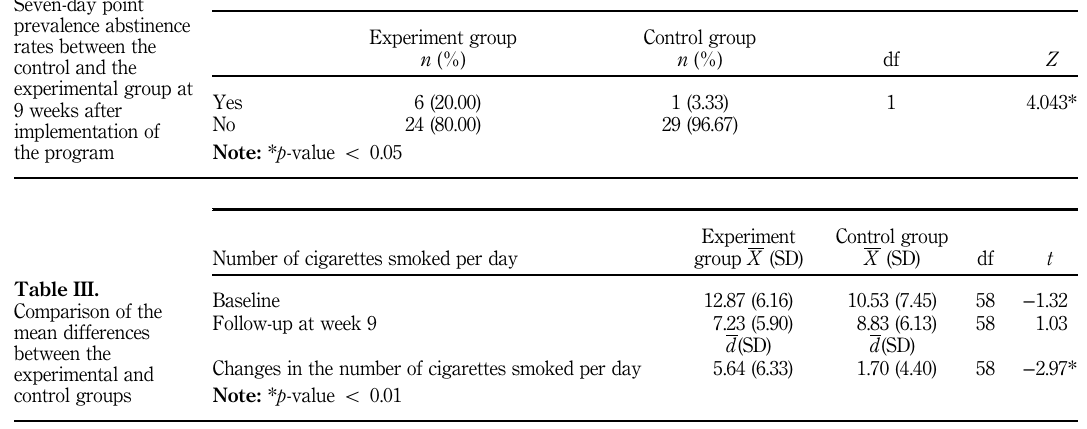
Experiment group n (%)